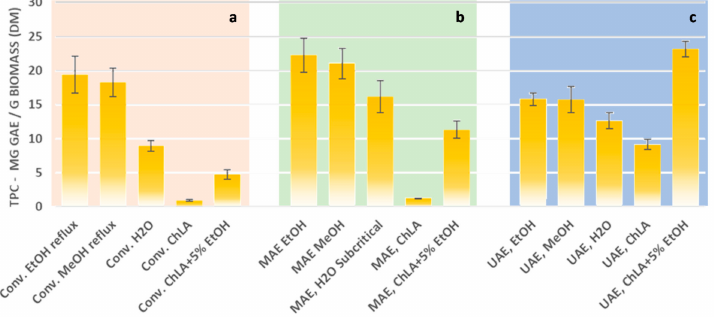
Figure 1. Comparative extractions of Potato-Peel (PP) under conventional ( a ) and non-conventional technologies (( b ) utilises microwave (MW), ( c ) ultrasound (US)) exploiting sustainable